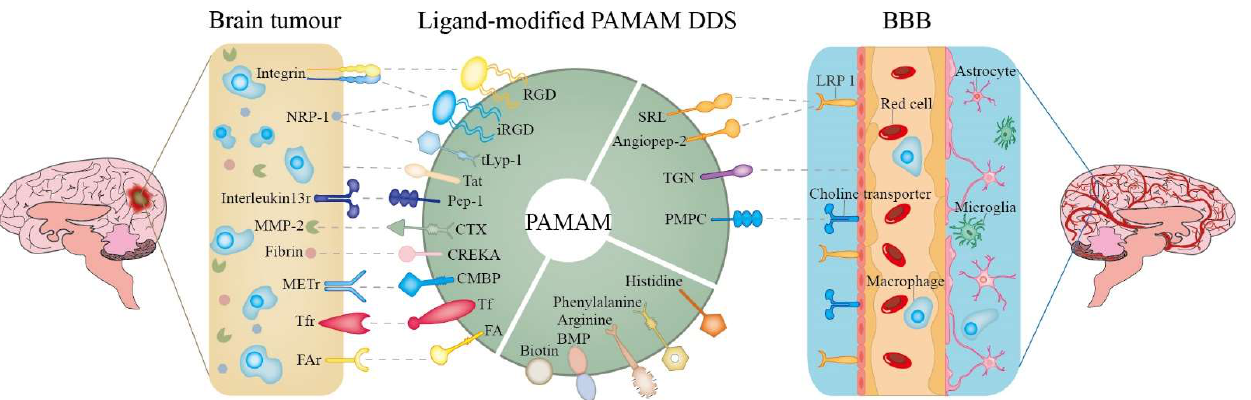
Figure 4. Schematic representation of targeting ligands and their receptors or targeting sites on the PAMAM DDS. NRP-1: neuropilin 1; MMP-2: matrix metalloproteinase-2; METr: mesenchymal transition factor receptor; Tfr: transferrin receptor; FAr: folic acid receptor; CTX: chlorotoxin; Tf: transferrin; FA: folic acid; PMPC: poly (2-methacryloyloxyethyl phosphorylcholine); BMP: bacterial magnetic nanoparticles; LRP 1: low-density lipoprotein receptor-related protein 1.